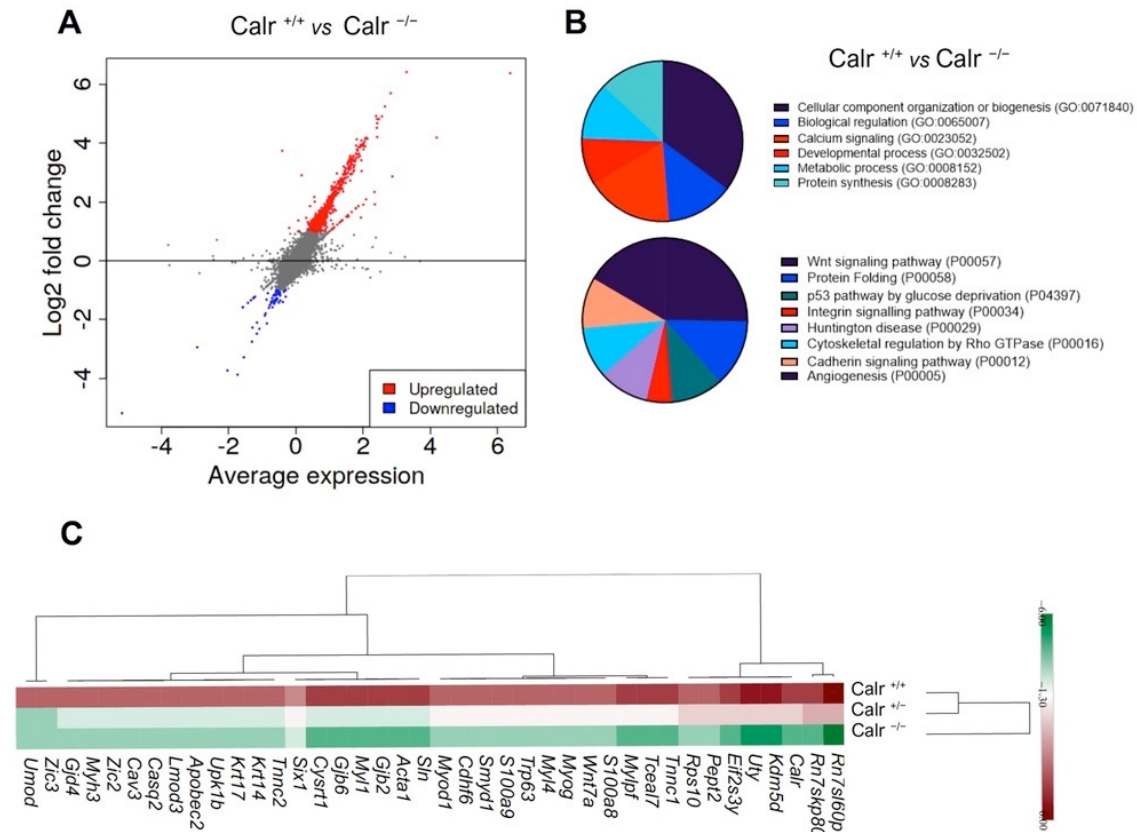
Figure 3. Comparative gene expression analysis of calreticulin knockout mice. ( A ): MA plot showing wide scale up- regulatedand down-regulated genes in Calr +/+ mice versus Calr − / − . Quantitative tests of the fold change (based on the normalized log transformed read count) were performed using Fisher’s exact test with a Benjamini–Hochberg correction ( p < 0.05) and non significant genes are represented in gray. MA plot is used for displaying the differentially expressed genes in Calr +/+ vs. Calr − / − . ( B ): Distribution of the biological processes of the down-regulated genes in Calr − / − compared to Calr ++- . The classification of the identified genes was carried out using a DAVID bioinformatics tool. The gene symbol was used to categorize the gene ontology annotations, e.g., biological processes. ( C ): Enrichment analysis of the top genes found to be significantly regulated between the three genotypes (Calr +/+ , Calr +/ − and Calr − / − ). The comparative analysis is represented as a heatmap (FC < − 2 and FC > 2).